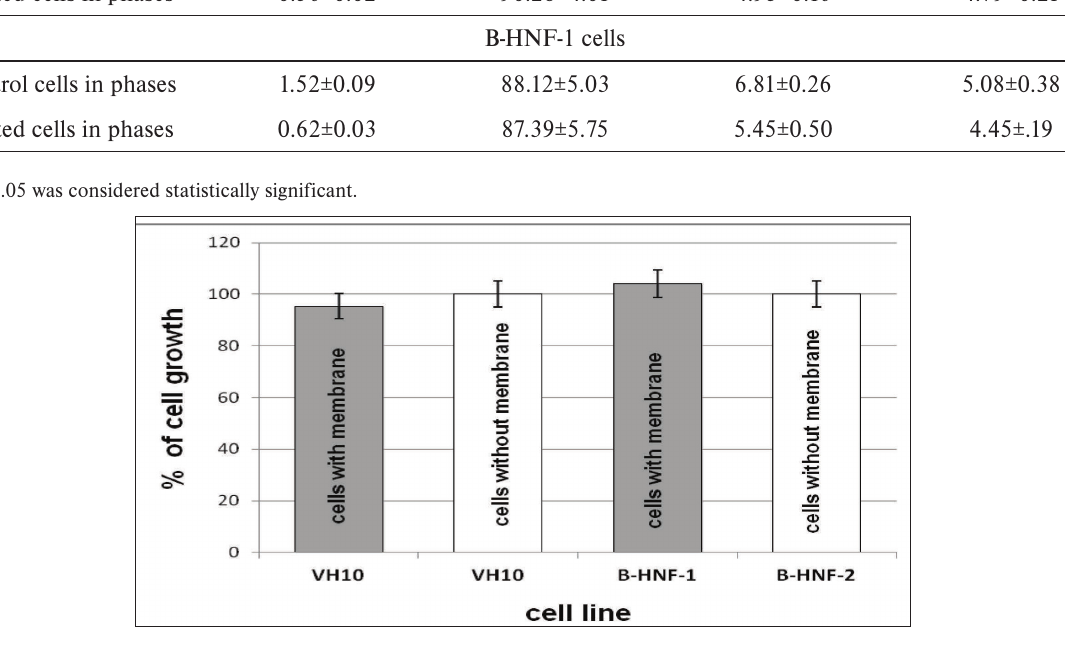
Fig. 3. Percentage of LDH release from VH10 and B-HNF-1 cells in/without pres- ence of coladerm-beta glucan membrane.